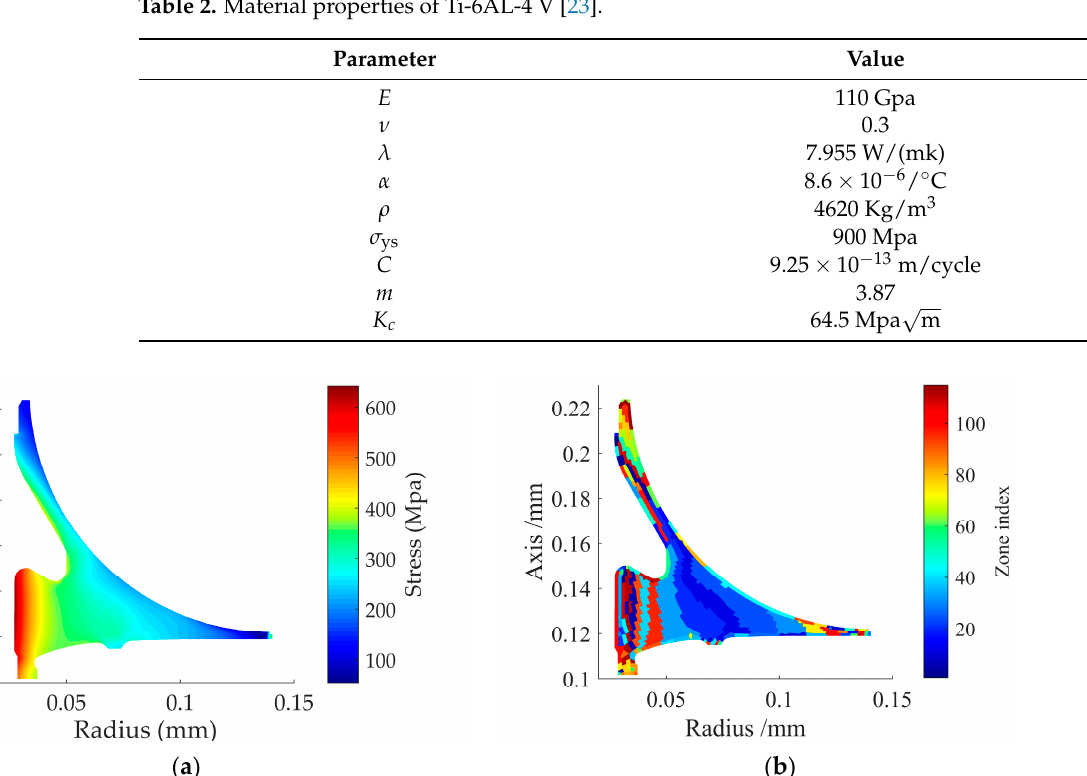
Figure 5. Finite element analysis and zone division: ( a ) stress contour; ( b ) zone division.